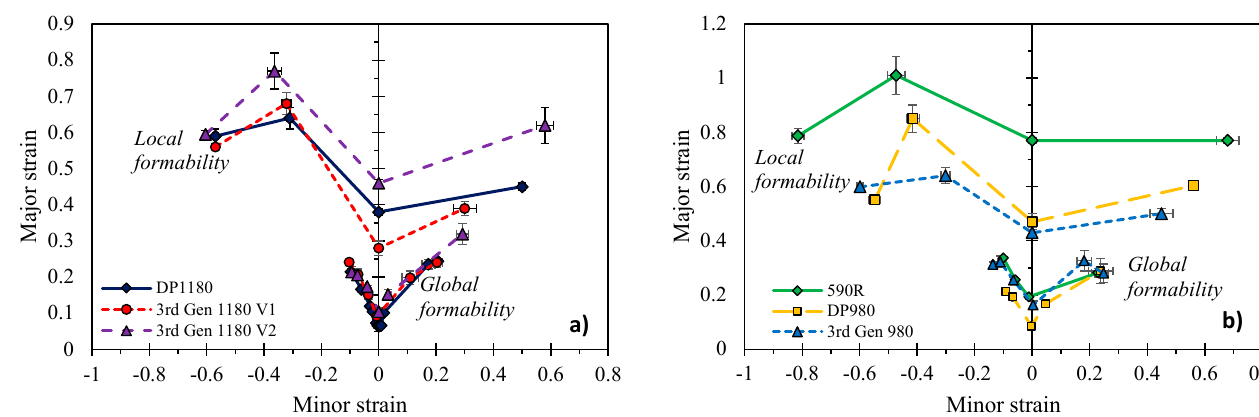
Figure 30. Comparison of the local and global formability in strain space for the 1180 MPa ultimate tensile strength ( a ) and the 590 MPa and 980 MPa strength steels ( b ).